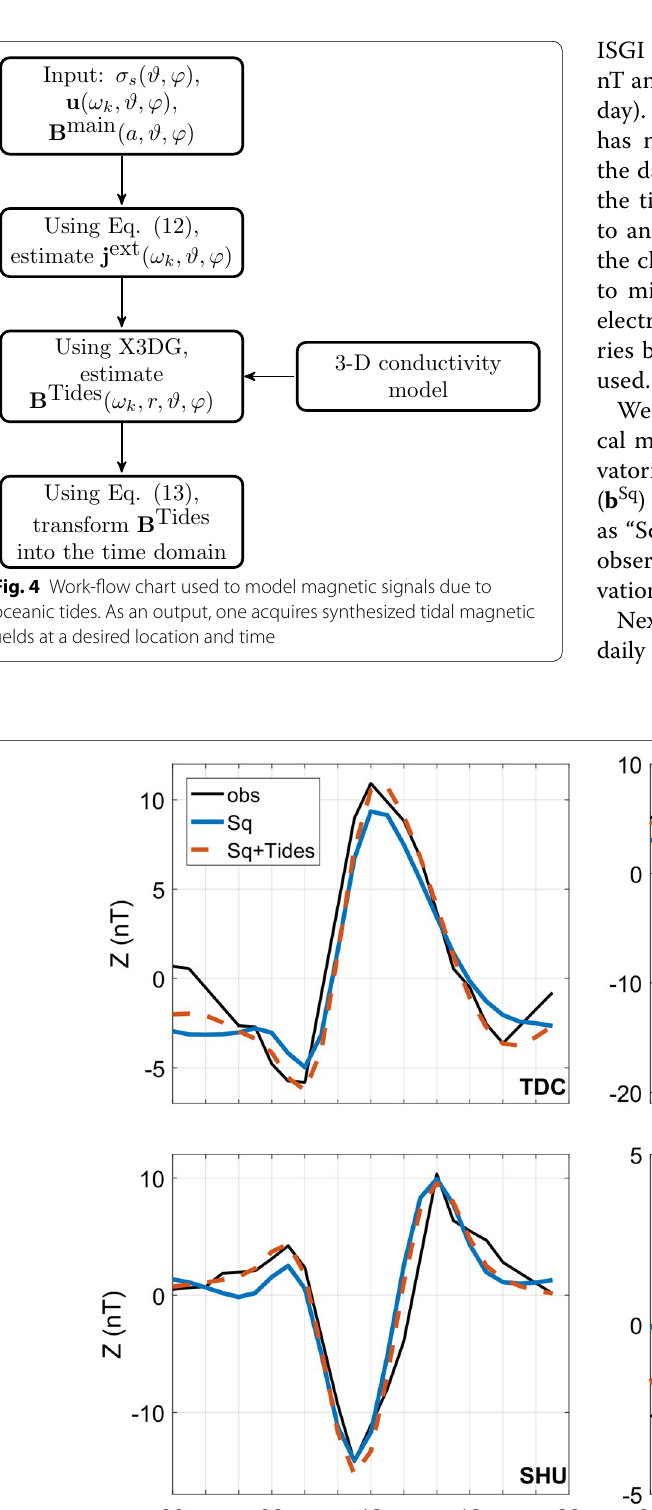
Tides magnetic fields on March 16, 2011 at the Tristan da Cunha (TDC), +